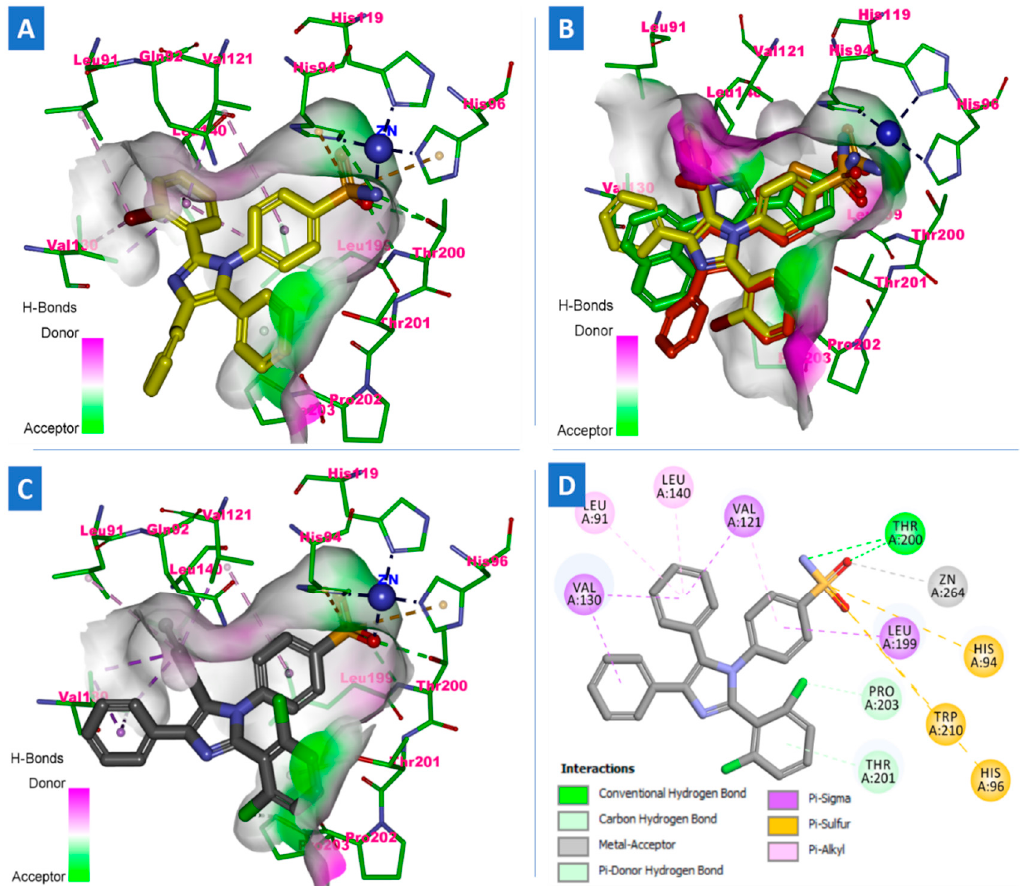
Figure 4. Comparison of docking and 2/3D binding modes of compound 5b (stick with carbons colored in yellow) and compound 5d (stick with carbons colored in grey) within the catalytic active site of CA-IX isoenzyme (PDB code: 5FL4); ( A ) 3D binding mode of compound 5b into active site of CA-IX isoenzyme; ( B ) the superimposition of 5g , 5b and 9FK docked poses within the catalytic active site of CA-IX isoenzyme; ( C ) 3D binding mode of compound 5d into active site of CA-IX isoenzyme; ( D ) 2D docking mode of 5d showing different types of interactions inside the active site of CA-IX isoenzyme. Zn +2 cation is presented as a blue sphere in coordination with His94, His96, His119 and -NHSO 2 shown in dashed dark blue lines. H-bonds were represented as dashed green lines. All hydrogens were removed for the purpose of clarity.